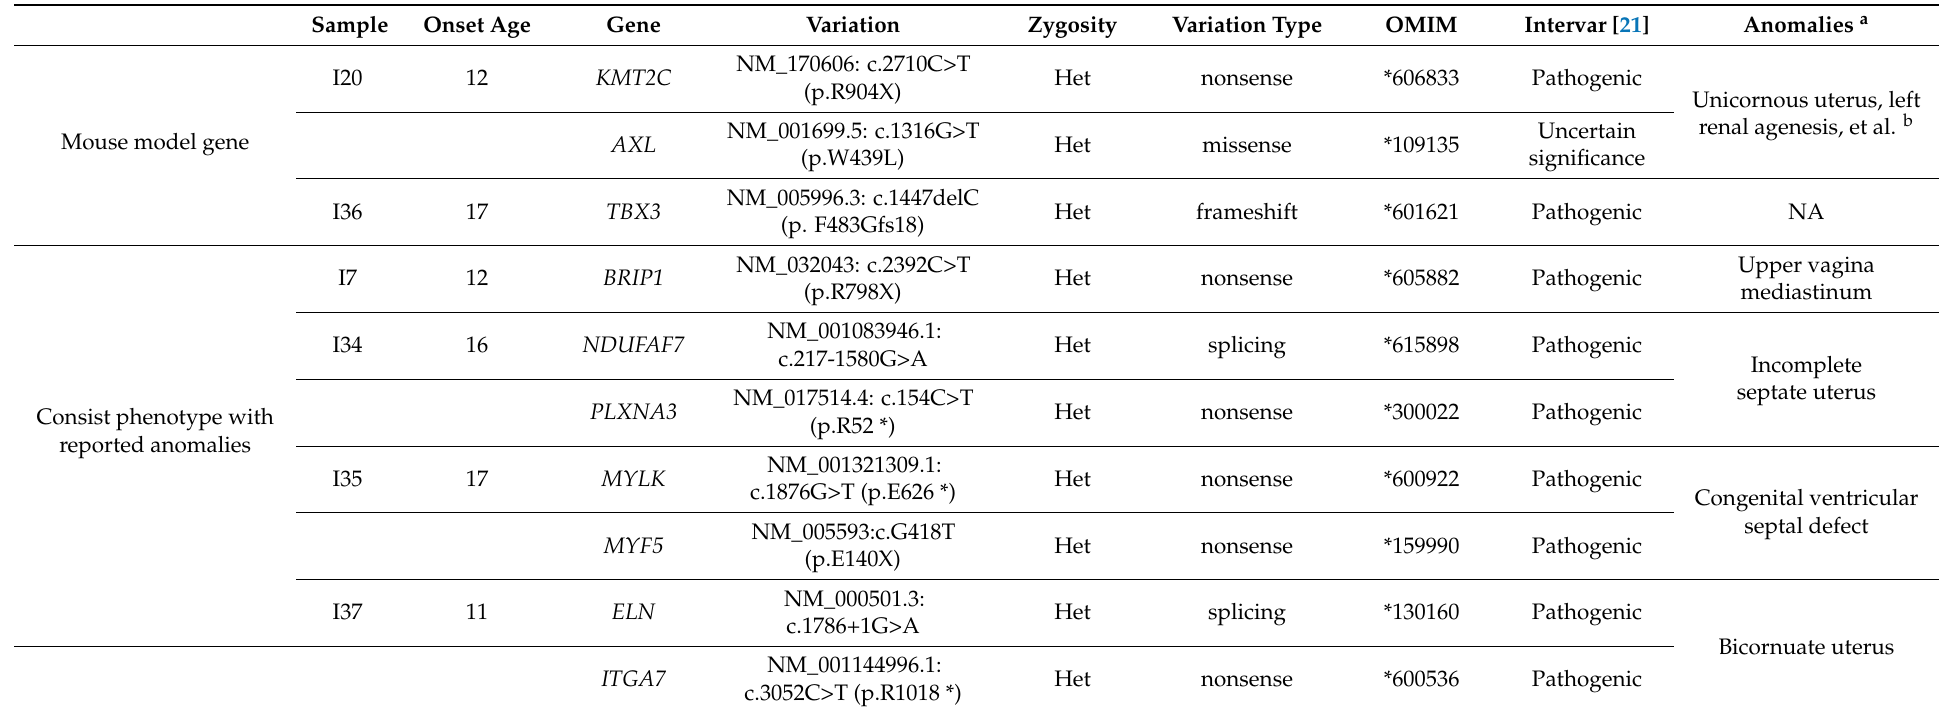
Table 2. Findings of genetic variants in our cohort with multiple